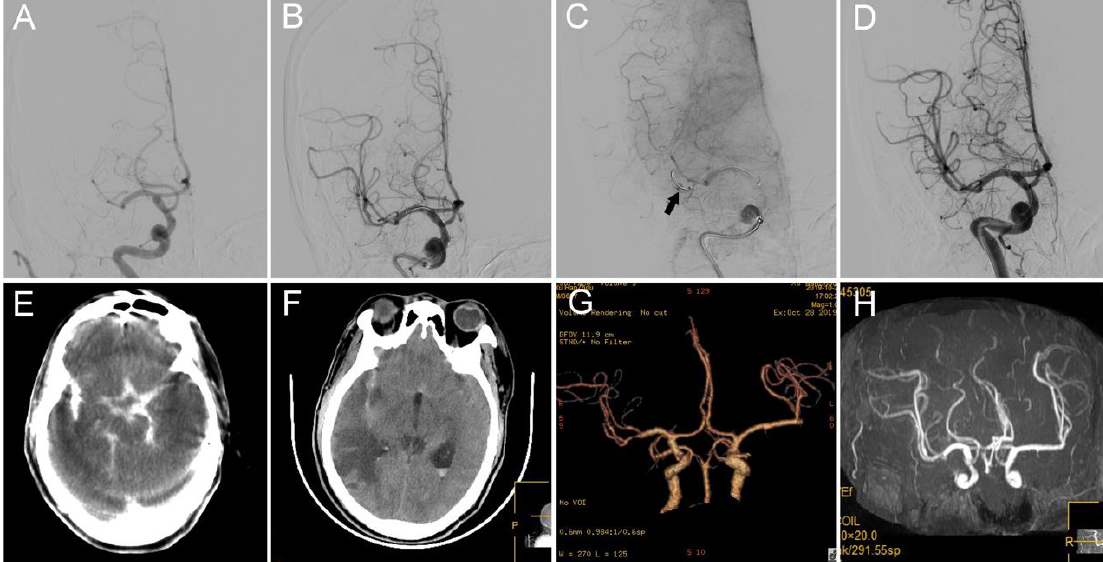
Figure 3. ( A ) DSA shows occlusion of the M1 segment of the right MCA. ( B ) The microcatheter advanced through the occlusion site, and a Solitaire 4 – 20 mm was unsheathed at the occlusion site. ( C ) Angiography showed contrast extravasation from the inferior trunk of the MCA (indicated by the black arrow). ( D ) No contrast extravasation after injection of 200 U thrombin via the microcatheter. mTICI 3 reperfusion was achieved when the microcatheter was re-advanced into the inferior trunk of the MCA over the microwire and retrieved back into the proximal segment of the MCA while the microwire remained in place. ( E ) Hyperdensity within the Sylvian fissure and ventricle was observed on C-arm CT performed during the procedure. ( F , G ) Hyperdense area dismissed on follow-up CT. ( G , H ) Patency of the culprit artery was observed on follow-up CTA and MRA. DSA: digital subtraction angiography; MCA, middle cerebral artery; mTICI: modified